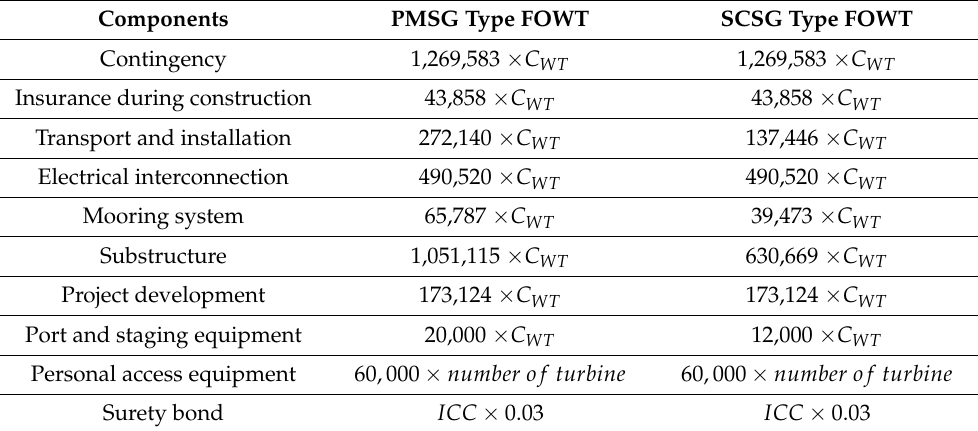
Table 6. Cost formulas for the balance of station cost (BOS) of the FOWTs [32,33].